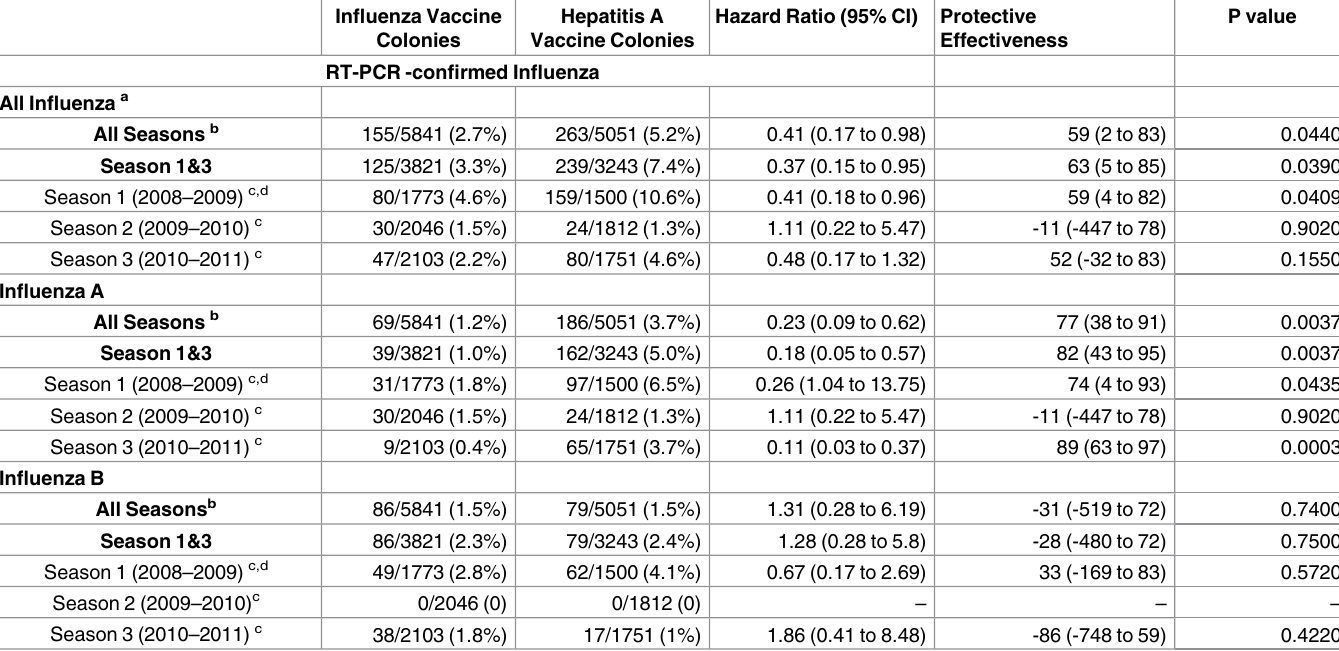
Table 4. Protective Effectiveness of Immunizing Children and Adolescents With Influenza Vaccine on All